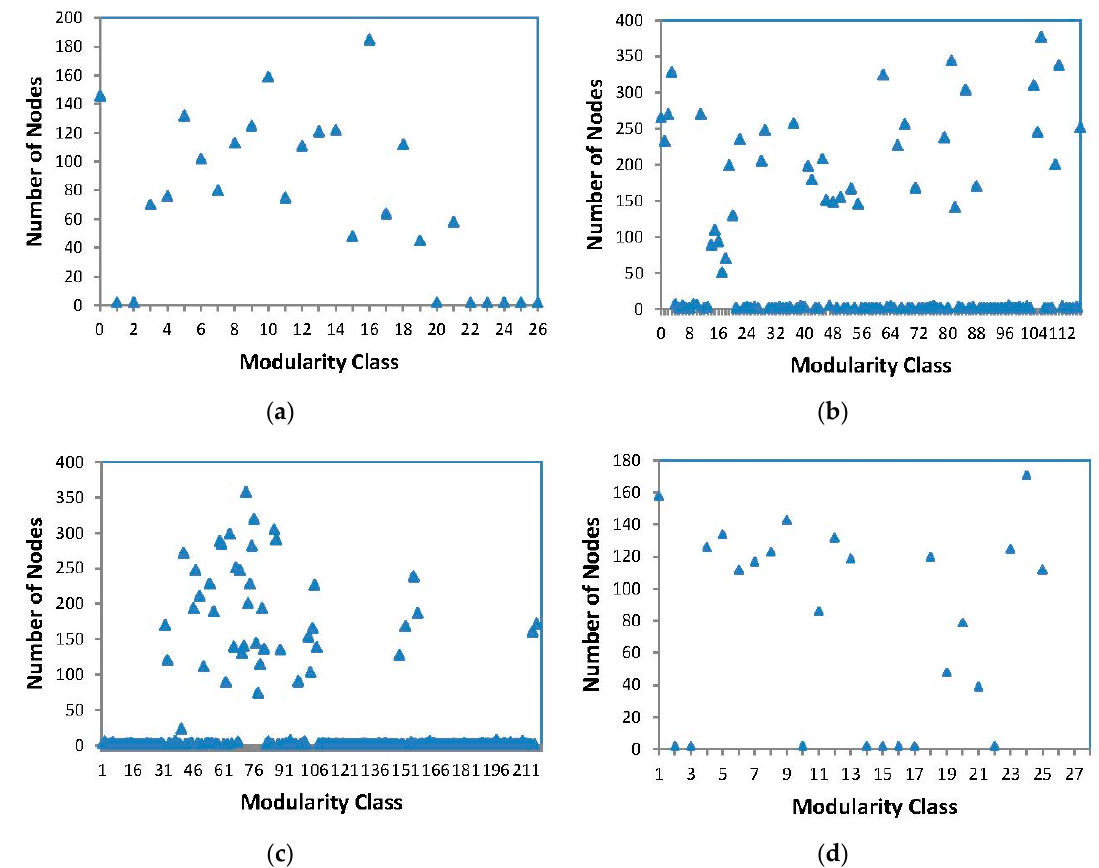
Figure 5. Distribution of node numbers in network community of sandstone: ( a ) 14.1%; ( b ) 16.9%; ( c ) 17.1%; ( d ) 24.6%.